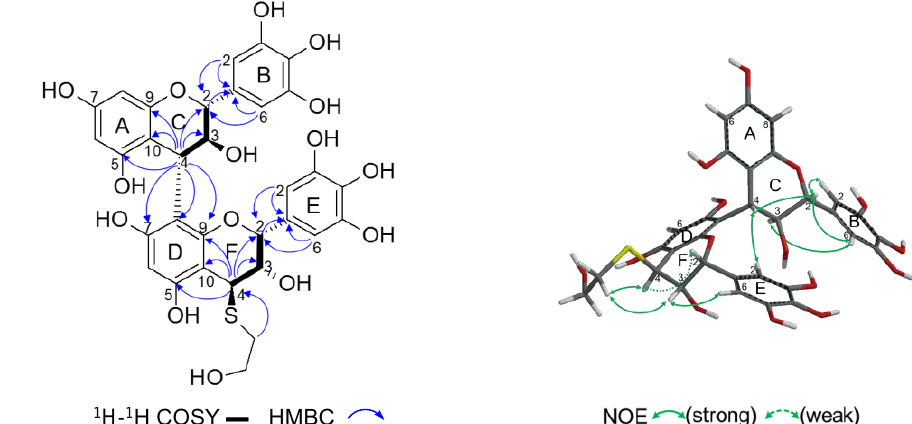
Figure 6. HMBC, 1 H- 1 H COSY, and NOESY correlations of 1 .